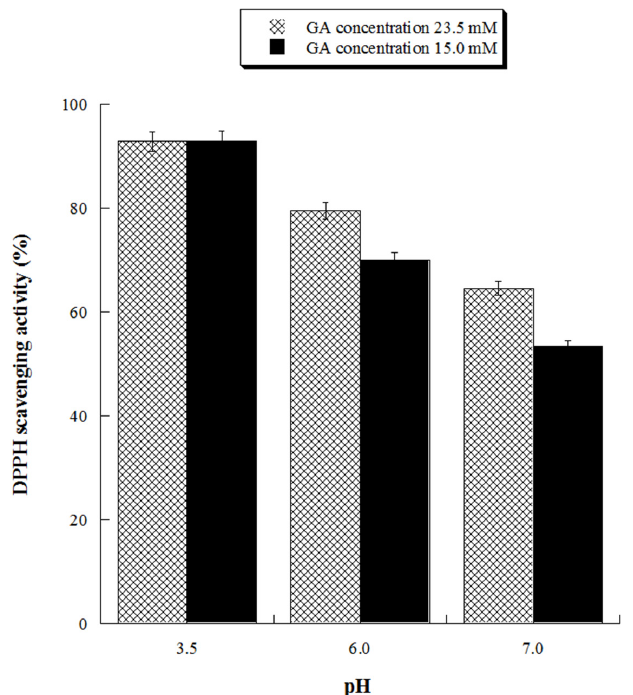
Figure 7. Scavenging activity against DPPH radicals of gallic acid (GA) at pH 3.5, 6.0 and 7.0. GA 23.5 mM concentration is equivalent to 4.0 g/L, GA 15 mM concentration is equivalent to 2.55 g/L.